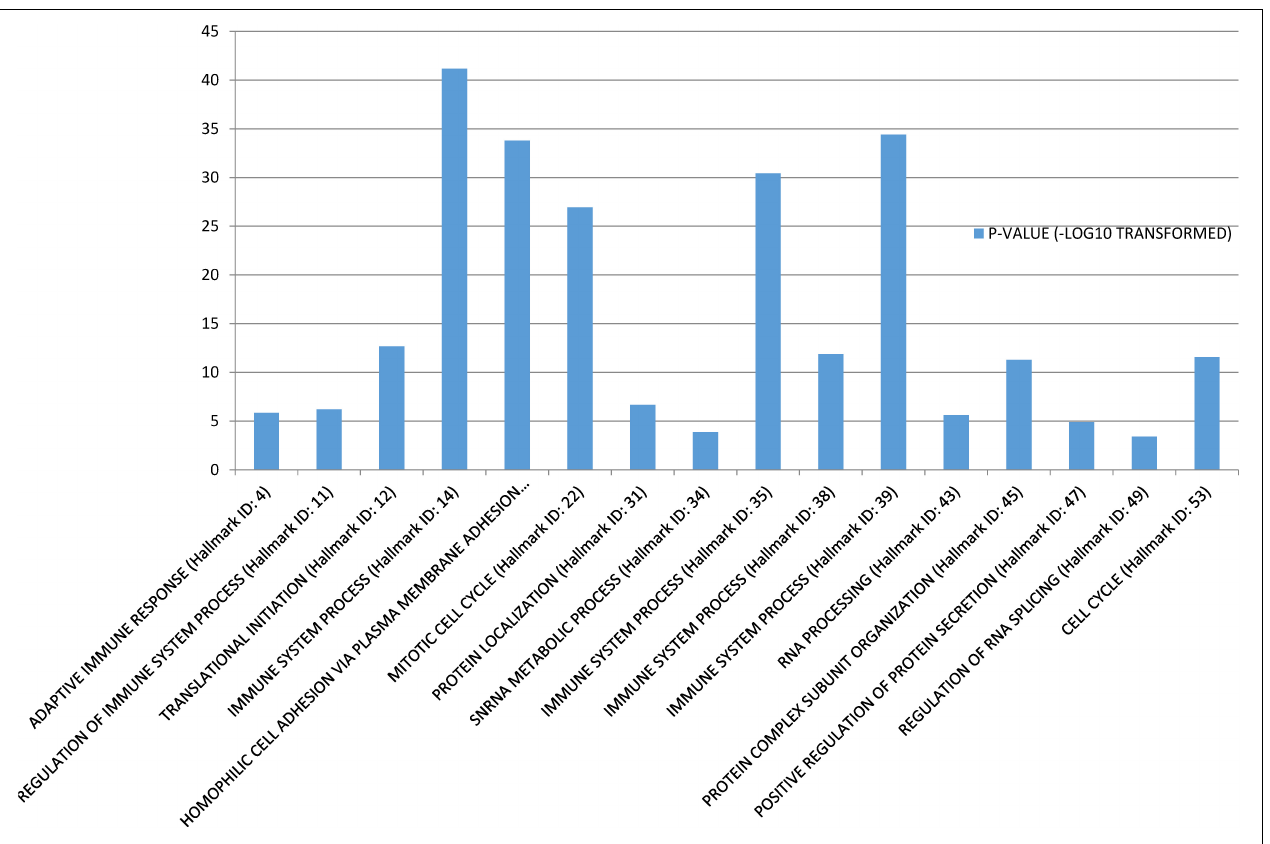
FIGURE 1 | Function annotations of the conservative